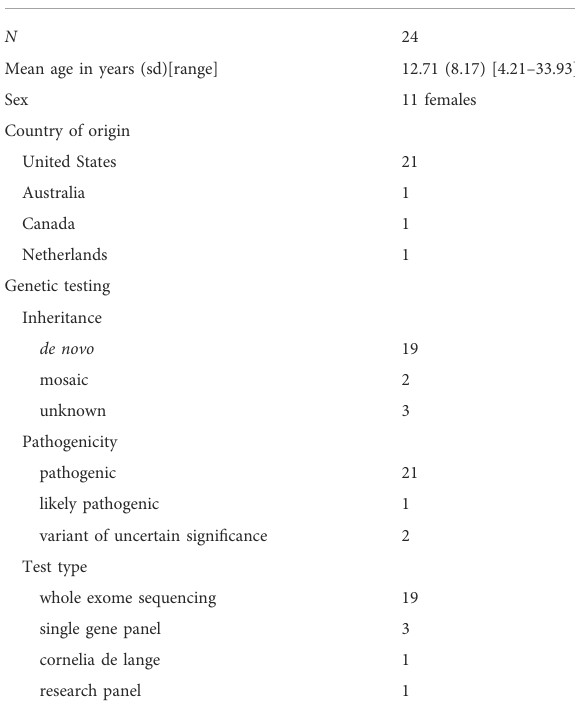
TABLE 1 Participant